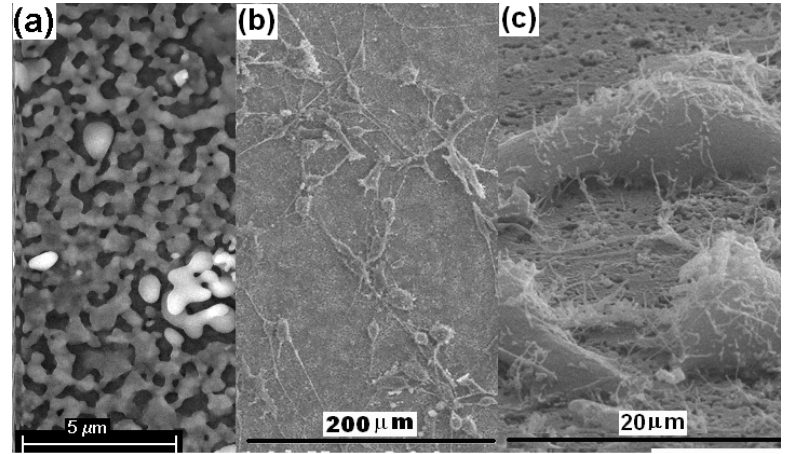
Figure 14. SEM micrograph ( a ) of 1.4 µ m of HA film on ~16 nm np-SiC obtained after thermal treatment at ~900 ◦ C for 12 h. ( b ) MG-63 cell attachment to 1.4 µ m thick HA on ~16 nm np-SiC at lower magnification and ( c ) higher magnification [2].